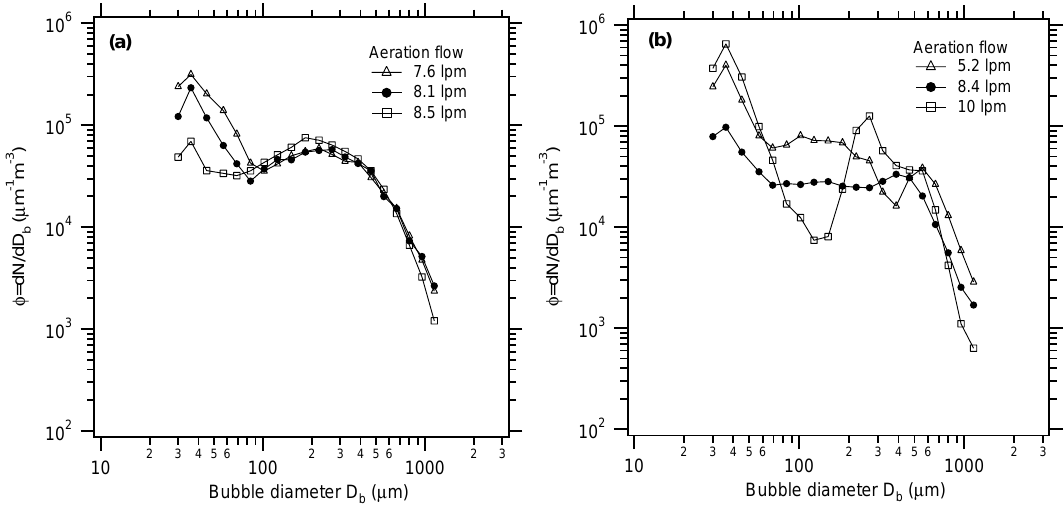
Fig. 3. Bubble population distribution versus bubble diameter for the plume generated by the (a) aquarium diffuser and (b) glass sintered filter at different aeration flows.